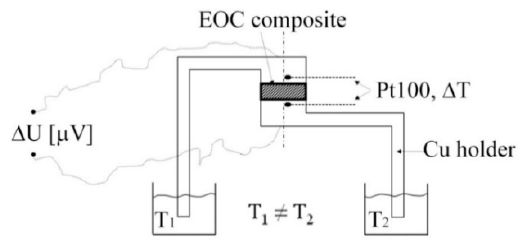
Figure 1. A schematic illustration of the set up for the measurement of electric voltage generated between the hot and cold ends of the Cu / composite / Cu thermoelectric device as a response to a temperature di ff